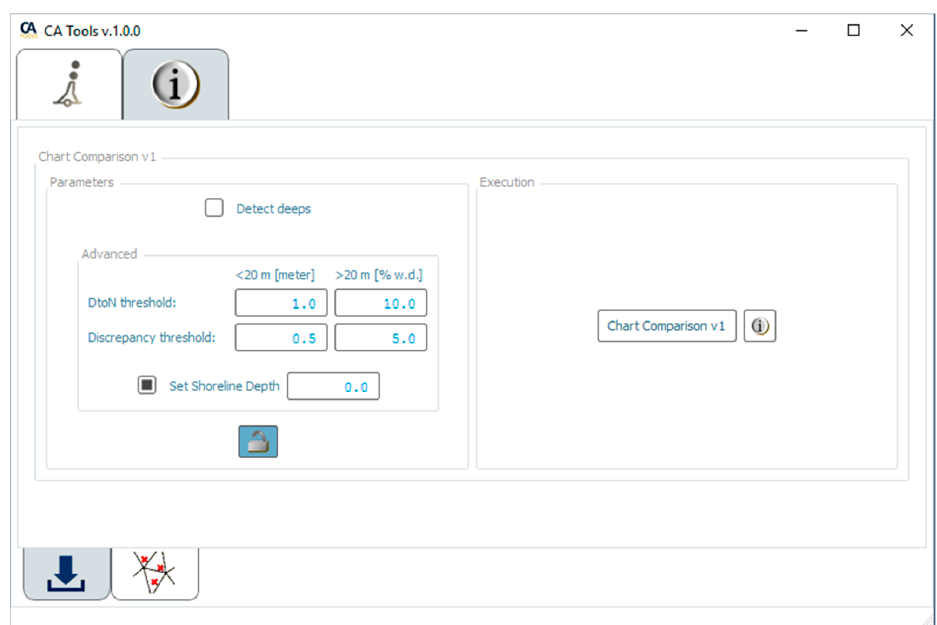
Figure 7. Screenshot of the tab widget present in the HydrOffice CA Tools application. The widget exposes, on the left area, certain algorithm parameters.